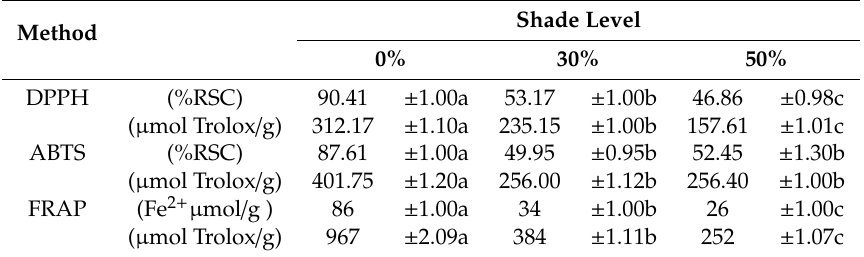
Table 2. Antioxidant activity of extracts obtained from the plants grown under various